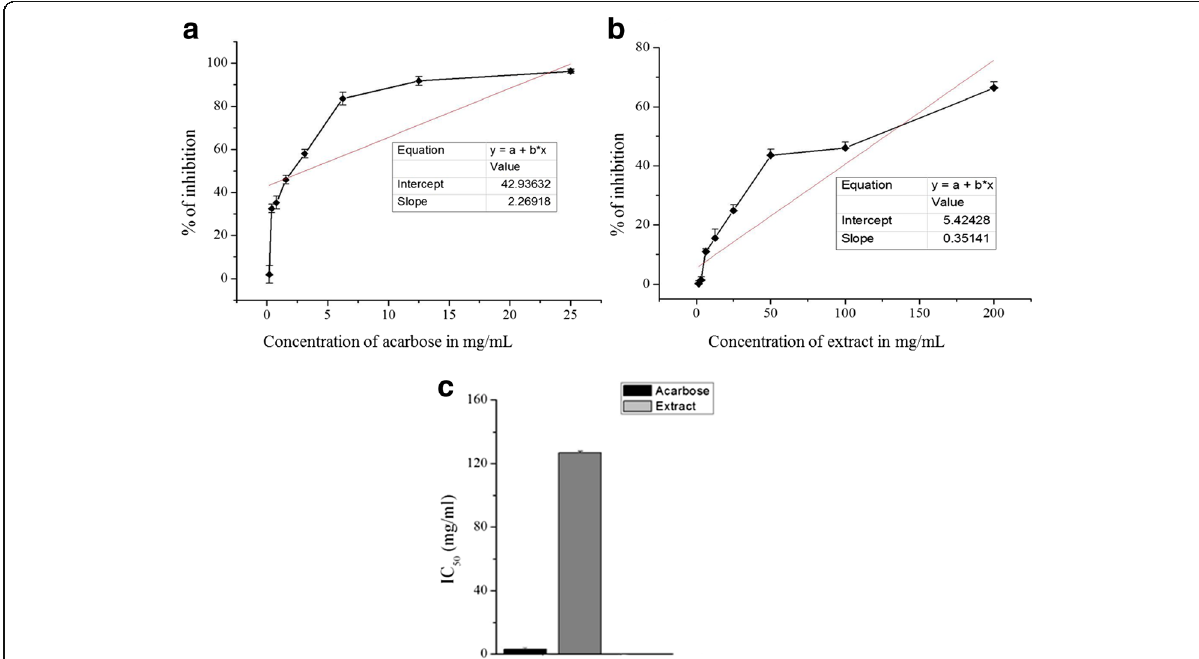
Fig. 1 α -amylase inhibition activity of acarbose and C. crepidioides in starch-iodine assay. a Percentage inhibition of acarbose ( b ) 80% methanol extract of C. crepidioides and ( c ) IC 50 of treatment groups on α -amylase enzyme in vitro. Values were represented as mean ± SD ( n =